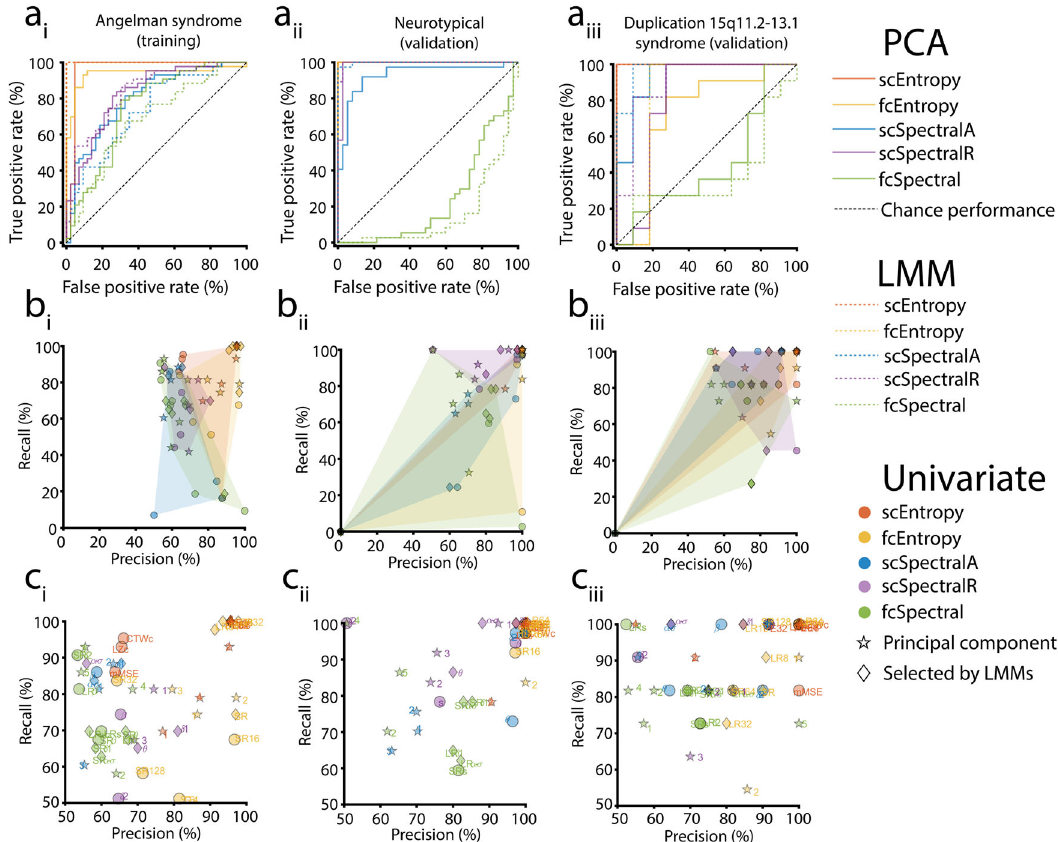
Fig. 3 Classi fi cation performance of EEG features in each cohort. Receiver operating characteristic curves color-coded by category ( a ) for each the AS training set (1), NT validation set (2), and the Dup15q validation set (3) all show larger AUCs for entropy features than for corresponding (i.e., single- channel or functional connectivity) spectral features. Features selected using PCA are shown with solid lines and features selected using LMMs are shown with dashes lines. To visualize the usefulness of models trained on individual features, we plotted precision (i.e., positive predictive value) versus recall (i.e., sensitivity) for each feature color-coded by category ( b ); regularization was not performed for univariate models. Diamonds represent features selected using LMMs and stars represent PCs of a given feature category. To better visualize individual features, we separately plotted the upper quadrant of each precision versus recall plot with features labeled ( c ). For brevity, abbreviations are shorted to cut information given in color-coded labels, i.e., yellow symbols omit “ wSMI ” , green symbols omit “ dwPLI ” , blue symbols omit “ A ” , and purple symbols omit “ R ” . PCs (stars) are labeled according to rank (proportion of variance explained). Source data are presented in Supplementary Data 4 (a) and Supplementary Data 3 (b,